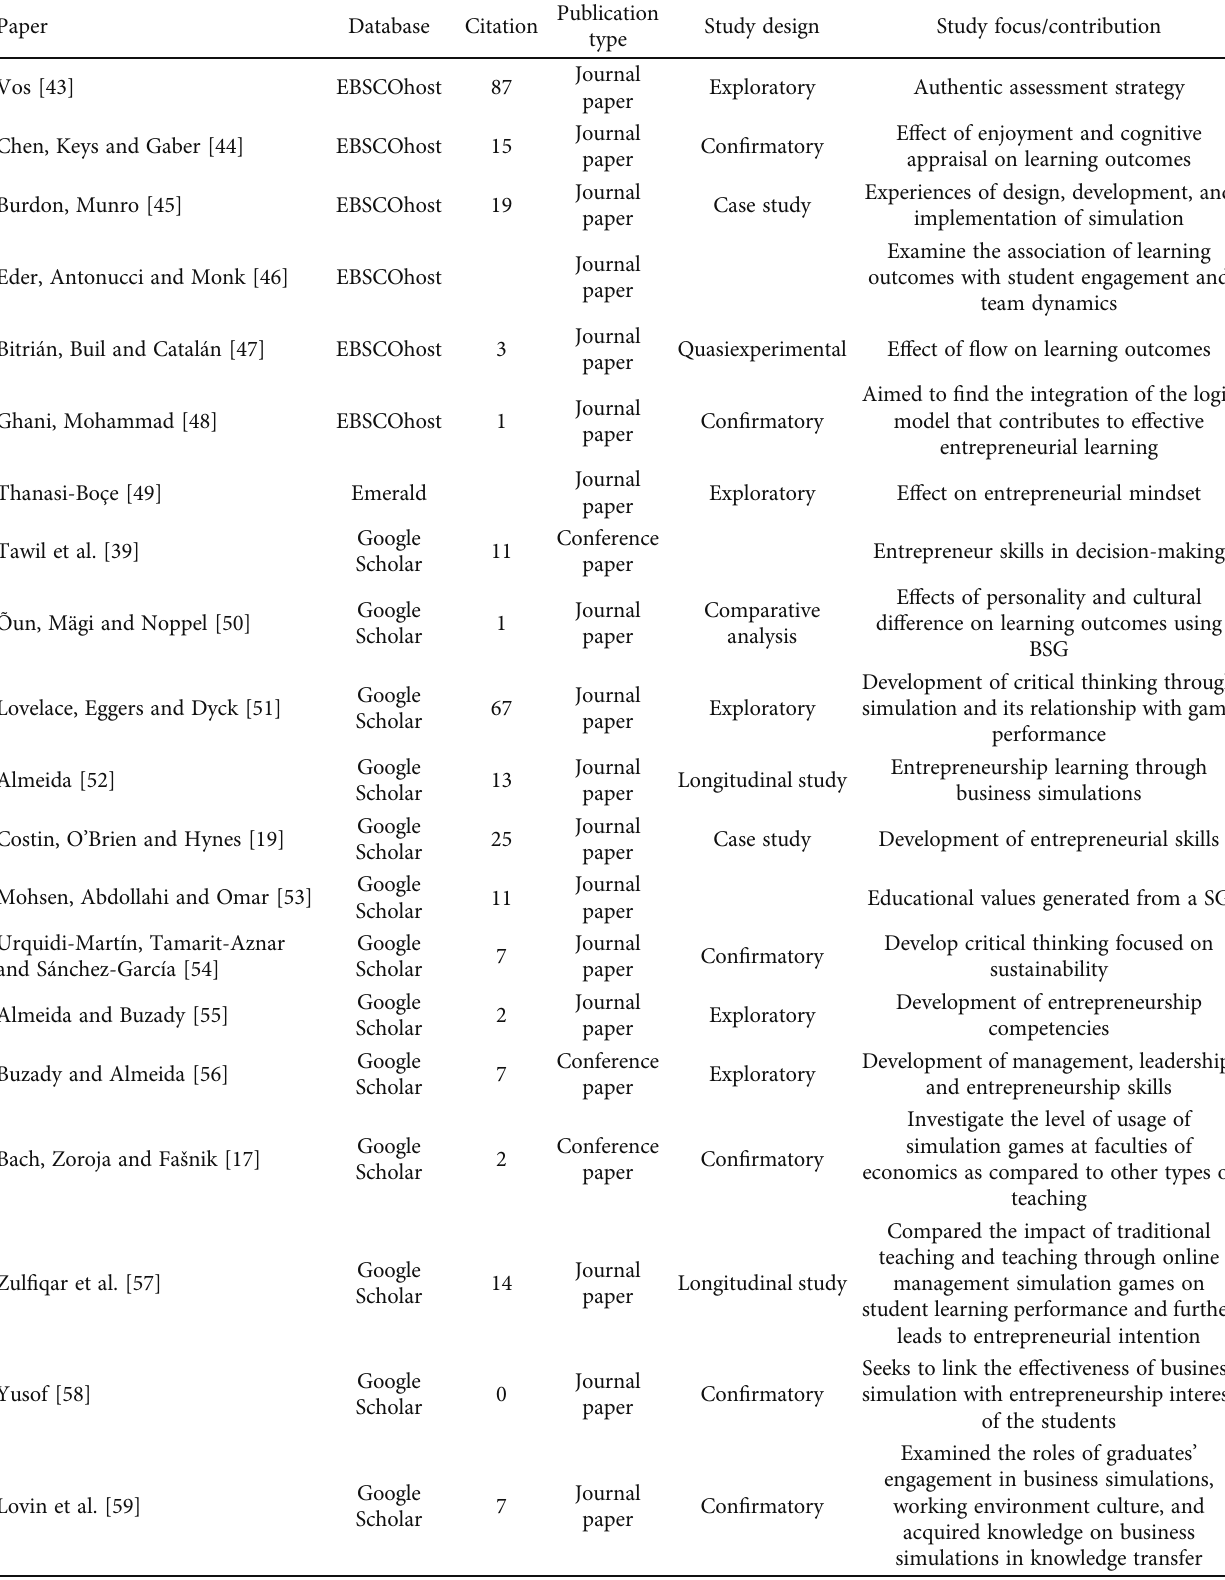
Table 4: Bibliographical overview of the selected